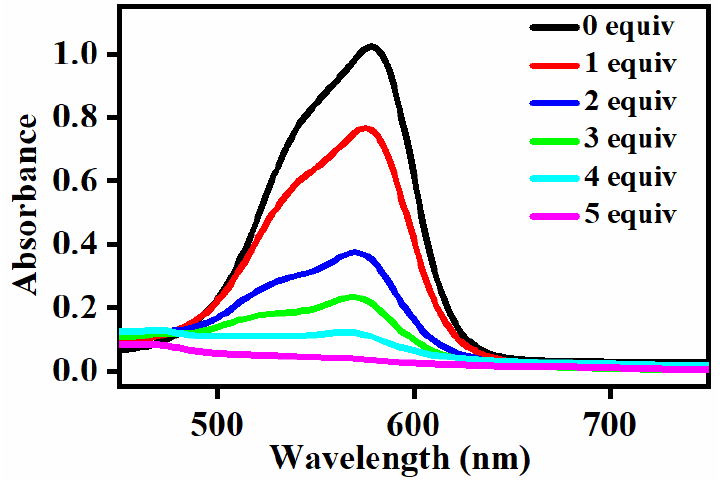
Figure 4. UV–vis spectral change observed in the degradation of gentian violet by various concentrations of PhIO. Conditions: gentian violet 0.05 mM; [Fe III (TCPP)] 0.005 mM; PhIO 0, 1, 2, 3, 4, 5 equiv; solvent MeOH; 303 K and reaction time 2.5 h. Table 1. [Fe III (TCPP)]-catalyzed degradation 1 of gentian violet by PhIO.